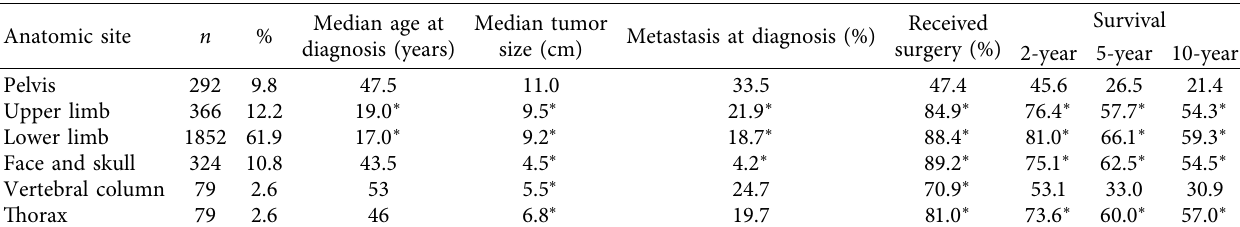
Table 3: Comparison of pelvis osteosarcoma to other anatomic locations and overall survival at 2, 5, and 10 years.